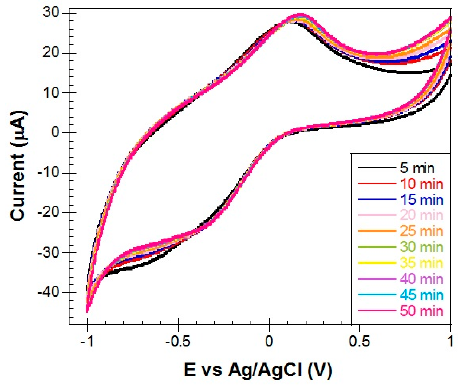
Figure 9. Cyclic voltammetry curves of different electrodes at a scan rate of 0.1 V/s: ( a ) Metglas 2826MB; ( b ) Metglas/ZnO; ( c ) Metglas/ZnO/Hb; and ( d ) all three curves plotted together, for comparison